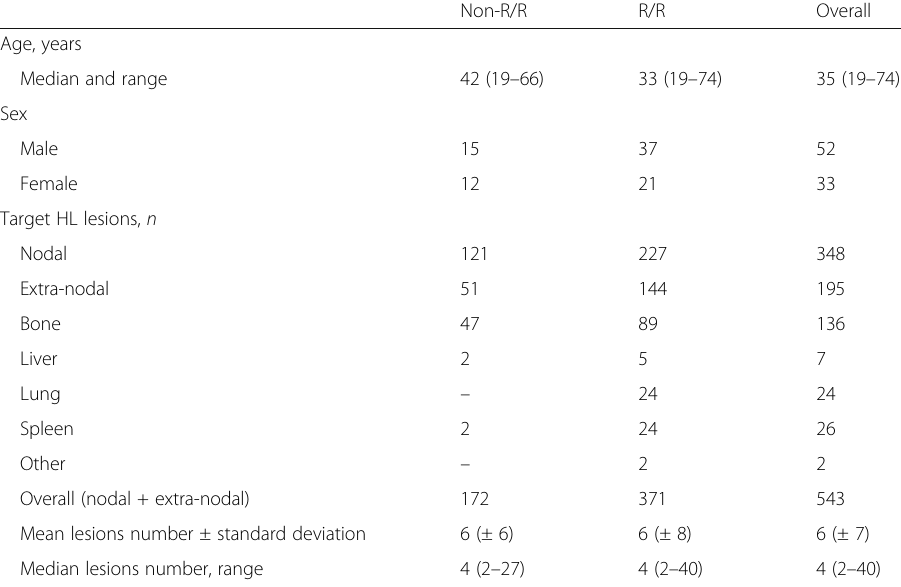
Table 3 Baseline characteristics of HL patients with multiple lesions Non-R/R R/R Overall Age, years Median and range 42 (19 – 66) 33 (19 – 74) 35 (19 –